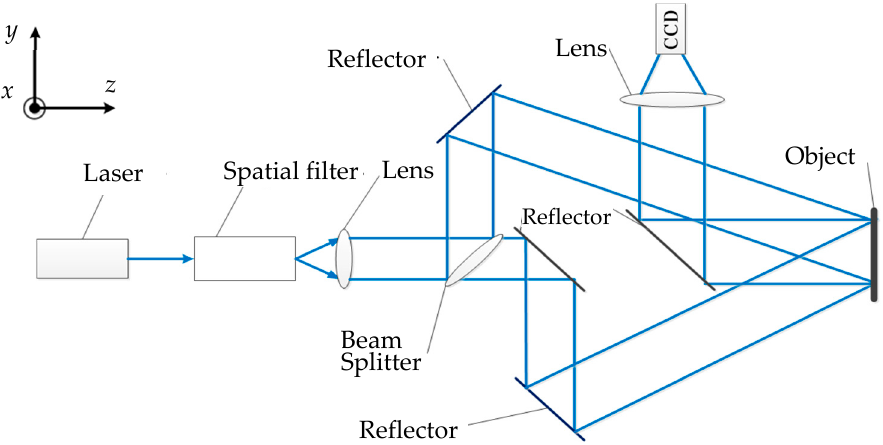
Figure 2. In-plane measurement .